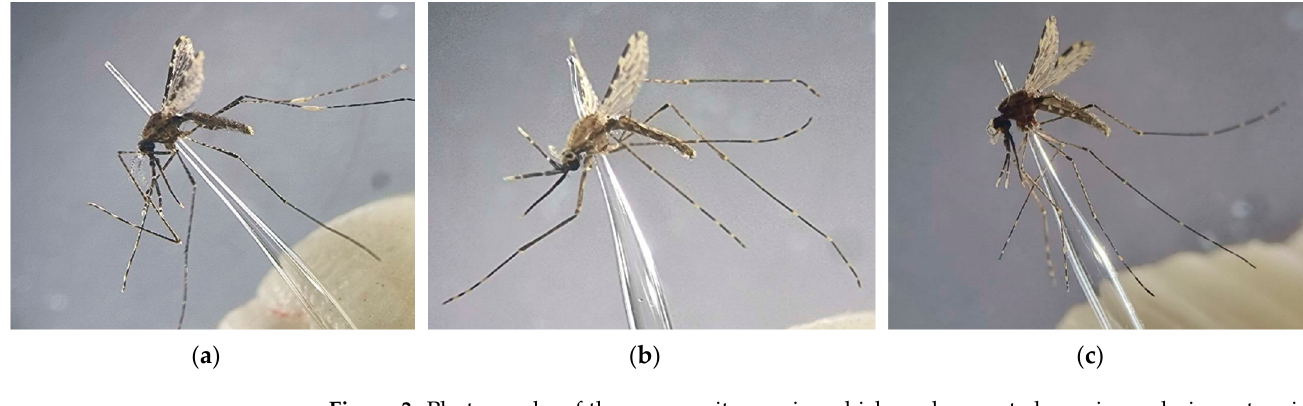
Figure 3. Photographs of three mosquito species which are known to be major malaria vectors in Vietnam: ( a ) Anopheles dirus ; ( b ) Anopheles minimus ; ( c ) Anopheles epiroticus